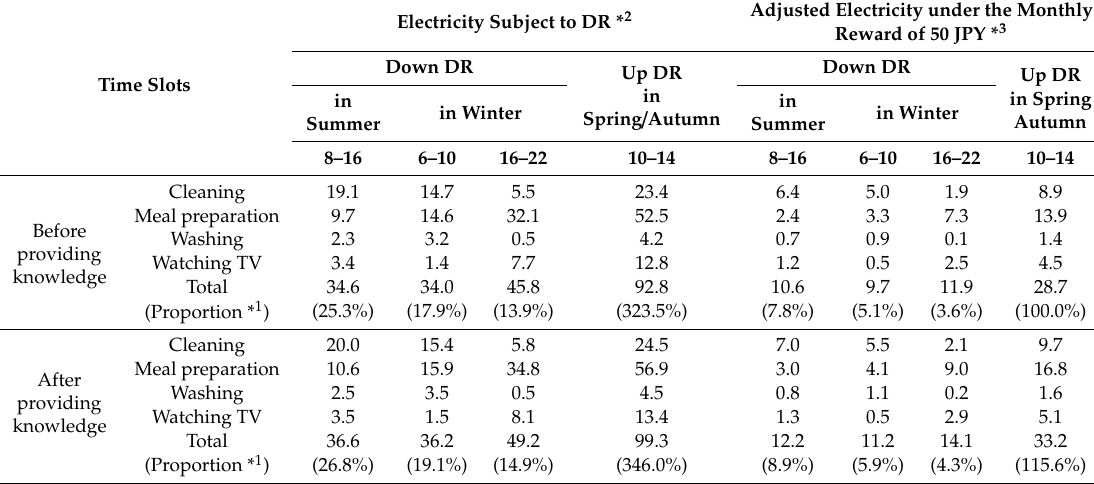
Table 4. Estimated result of adjustable electricity by time of day (Unit: GWh, excluding items with %).